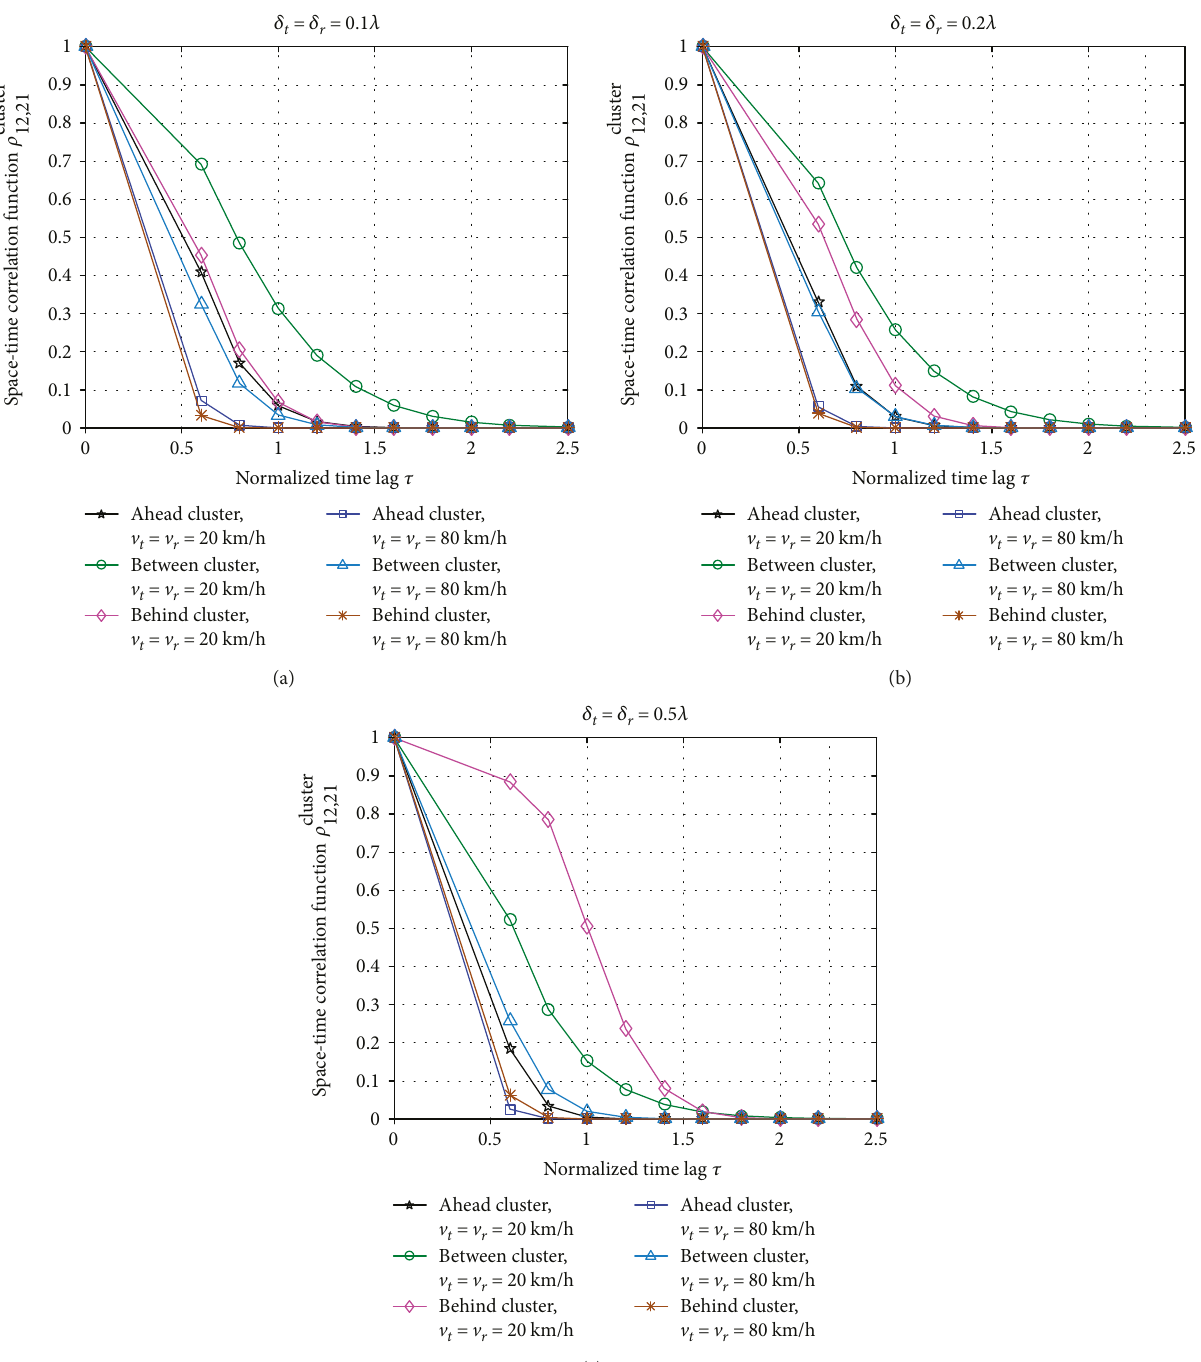
ff erent antenna element 12,21 of the reference model under di